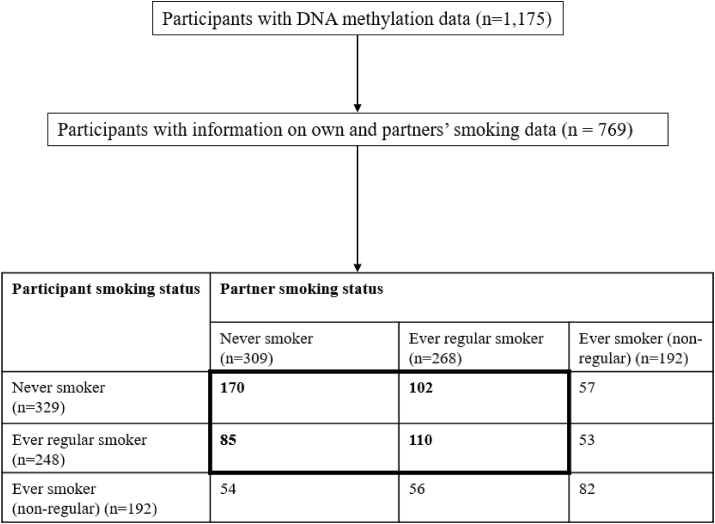
Flow diagram of participants stratified by smoking status in Epigenome-Wide Association Analysis (EWAS) models.